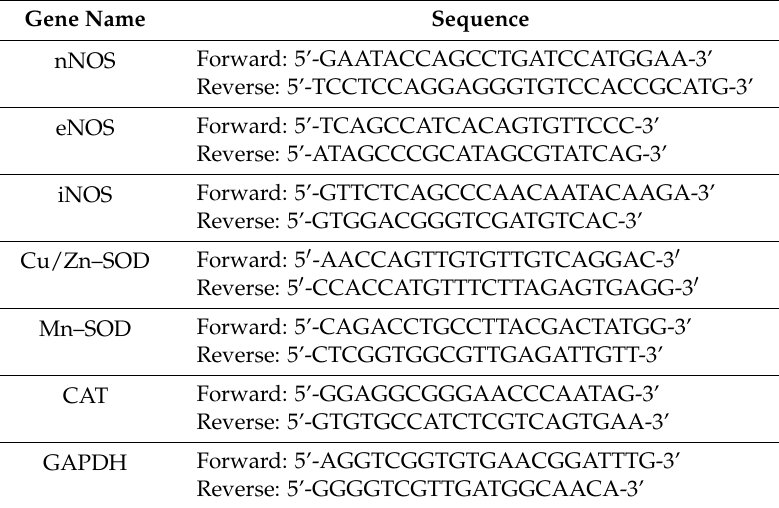
Table 1. Sequences of primers used in this